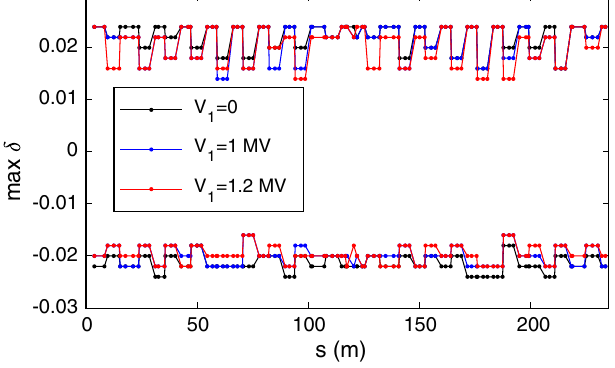
FIG. 6. The local momentum aperture determined from particle tracking simulation with crab cavities turned off ( V 1 ¼ 0 ), or with deflecting voltage at V 1 ¼ 1 MV or V 1 ¼ 1 . 2 MV.